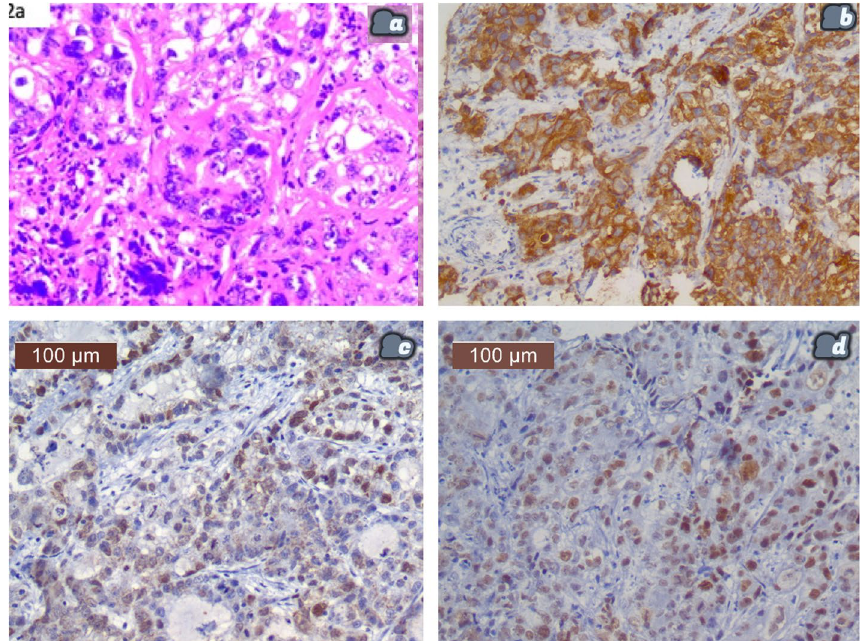
Fig. 2 The histomorphology image of Case 2 shows an irregular acinar pattern of tumor cells with round pleomorphic nuclei, prominent nucleoli, and a scant pale cytoplasm in 2a (H&E 200). Immunohistochemistry showed immunoexpression for panCK in 2b (IHC × in 2d